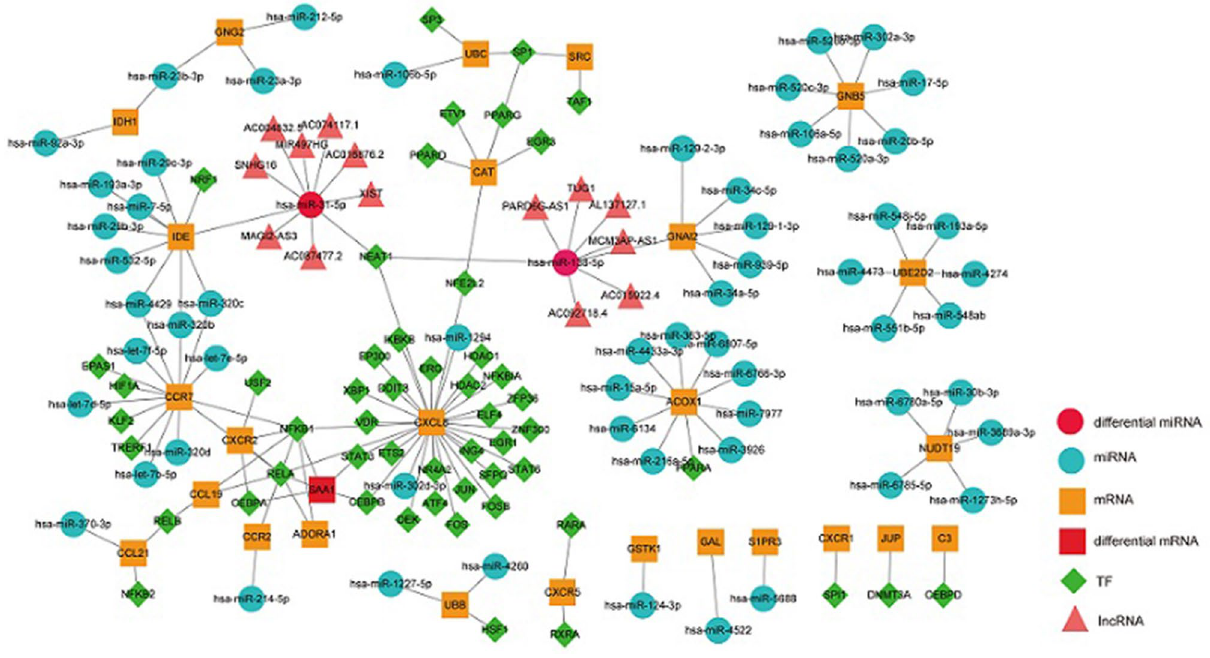
Figure 5. UC multi-factor network diagram made by Cytoscape software 3.8.2 (https ://cytos